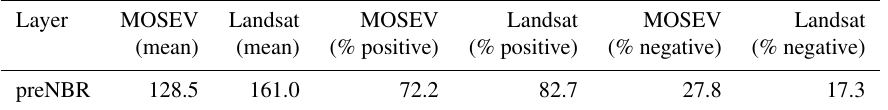
Table A2. Mean values and proportion of positive and negative values of the pre-burn NBR spectral index included in the MOSEV database and the equivalent obtained from 13 Landsat-8 scenes randomly distributed across the globe ( n = 32163). Layer MOSEV